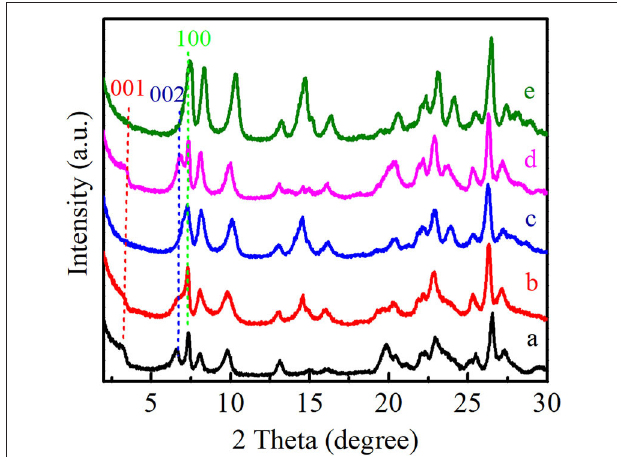
FIGURE 3 | XRD patterns of Ti-MWW-AM (a), Ti-MWW-AT (b), Ti-MWW (c), R-Ti-MWW-PI (d), and R-Ti-MWW-PI-cal